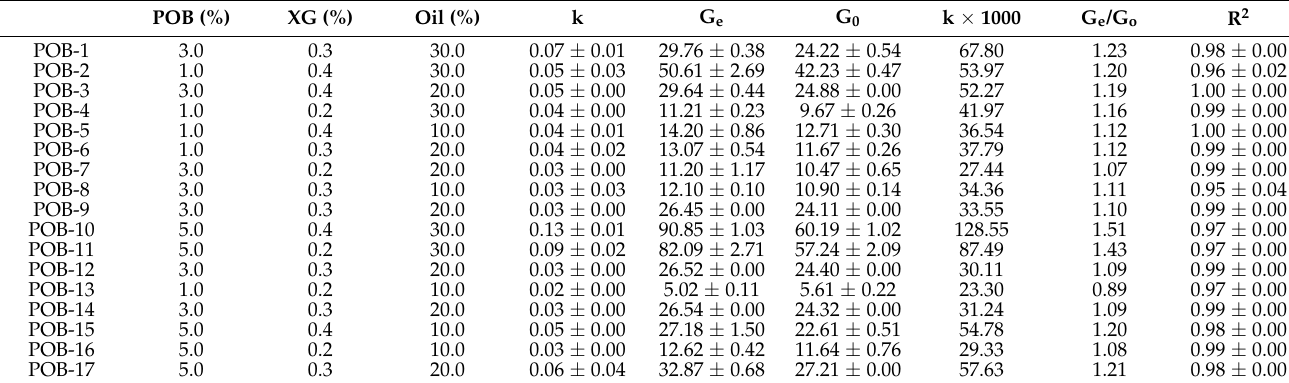
Table 3. Second-order structural kinetic model parameters for